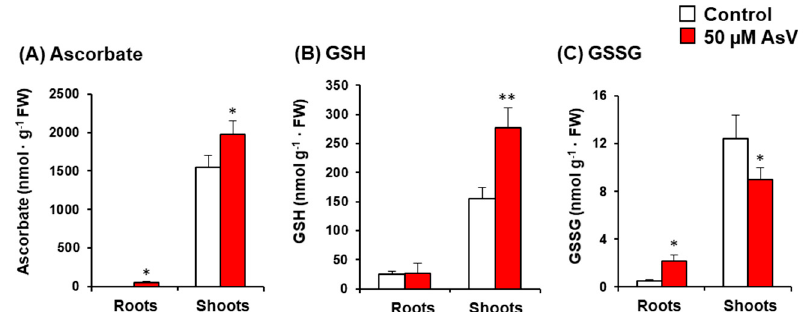
Figure 7. Content of ascorbate and glutathione (reduced and oxidized) in roots and shoots of 26-d-old rice seedlings grown in hydroponic solutions supplemented the last 12 days without (control) and with 50 μ M AsV. ( A ) Ascorbate. ( B ) Reduced glutathione (GSH). ( C ) Oxidized glutathione (GSSG). Data represent the mean ± SEM of at least three different experiments. Asterisks indicate that differences with respect to control (0 μ M AsV) values were statistically significant at p < 0.05 (*), p < 0.01 (**) and p < 0.001 (***).